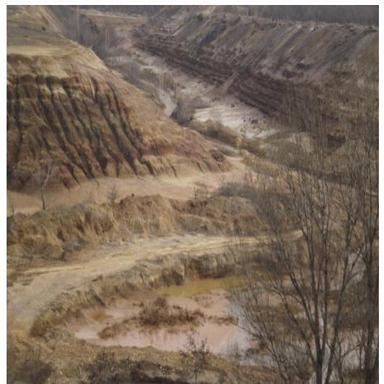
Tailing waste deposit Gornje Polje (Photo J.Djokic,2015).